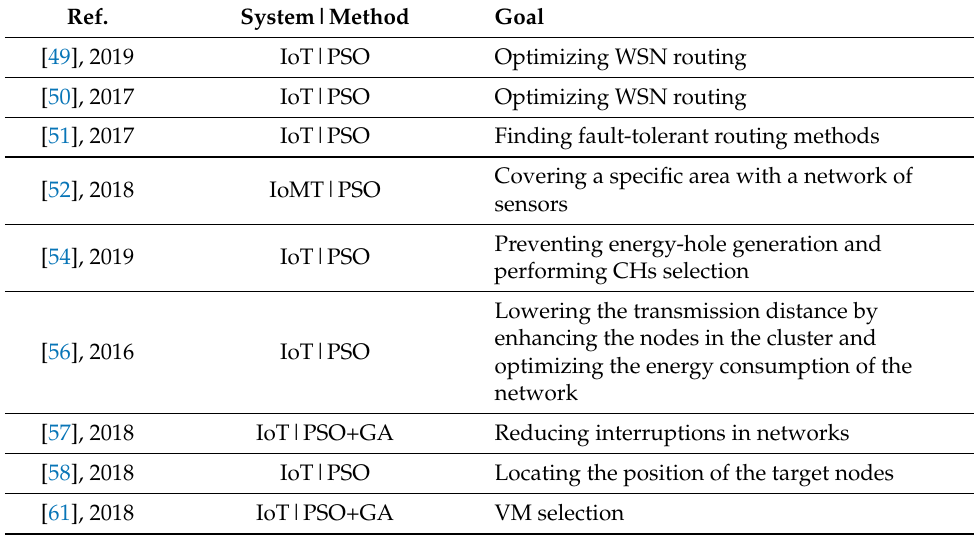
Table 2. Summary of analyzed works.